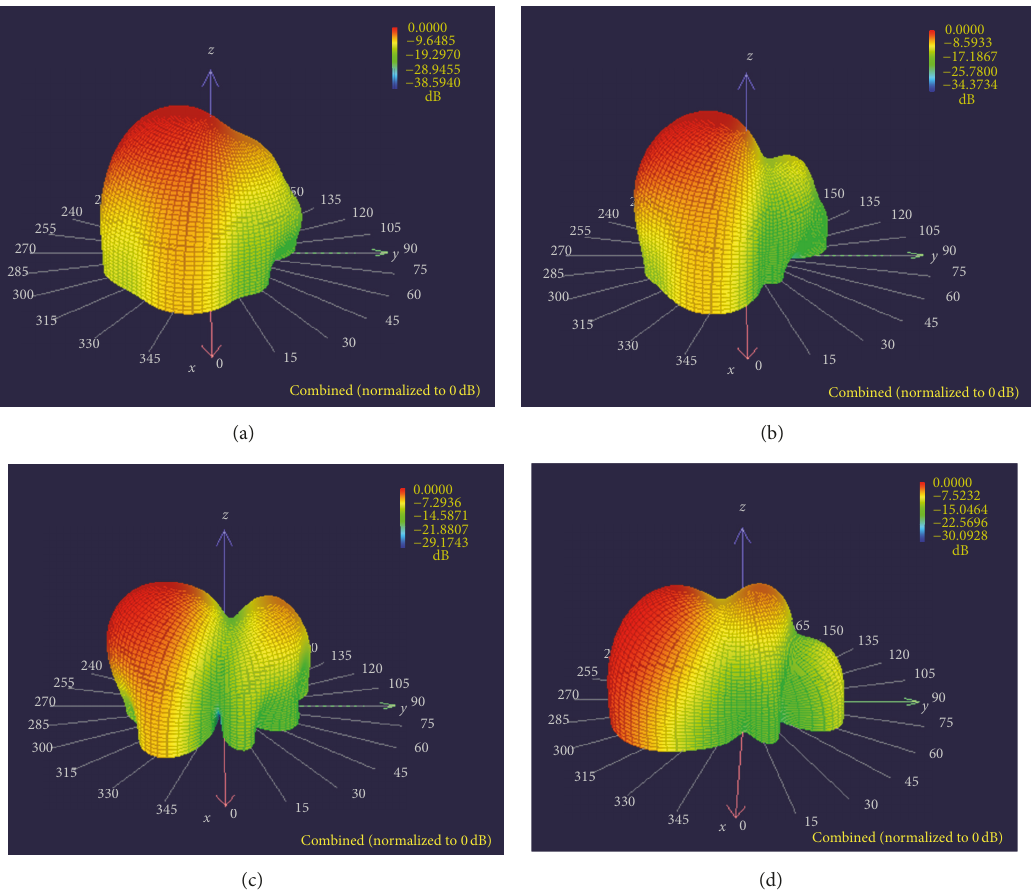
Figure 10: Measured 3D radiation patterns at 2.46 GHz for four configurations. Port 2 oriented in +𝑦 direction was connected to a signal generator, while port 1 was terminated to a 50 Ω matched load. (a) 𝑉 𝑆 = 8.5 V, 𝑉 SH = 10 V; (b) 𝑉 𝑆 = 7 V, 𝑉 SH = 9 V; (c) 𝑉 𝑆 = 6V, 𝑉 SH = 12 V; (d) 𝑉 𝑉 𝑆 = 5 V, SH = 4V.